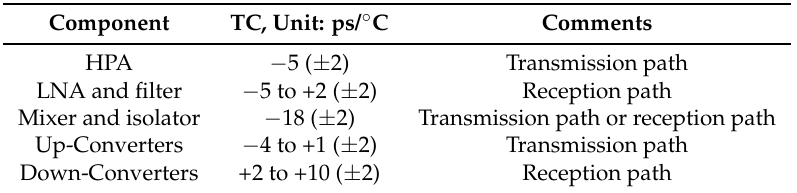
Table 1. Temperature coefficients (TC) of group delay for modules (measured at +5–+45 ◦ C, 40% relative